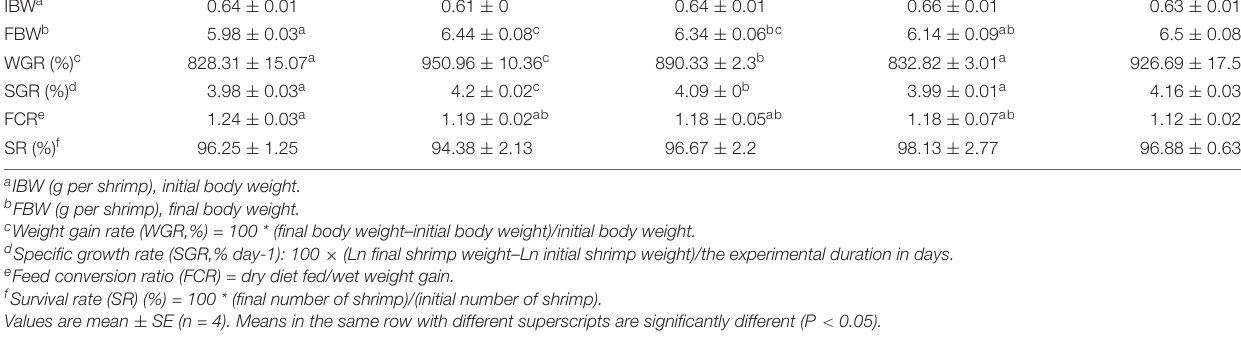
TABLE 3 | Growth performance of L. vannamei fed diet supplementation with/without lutein or astaxanthin for 56 days. C L1 L2 L3